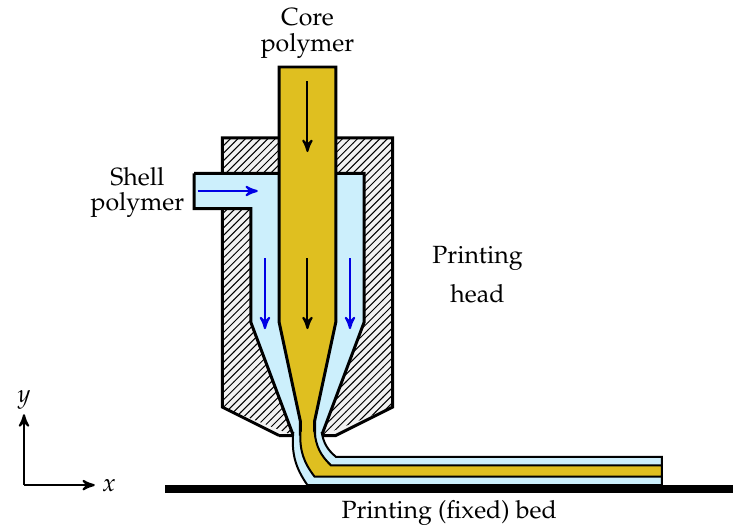
Figure 1. Two-dimensional schematic of core–shell 3D